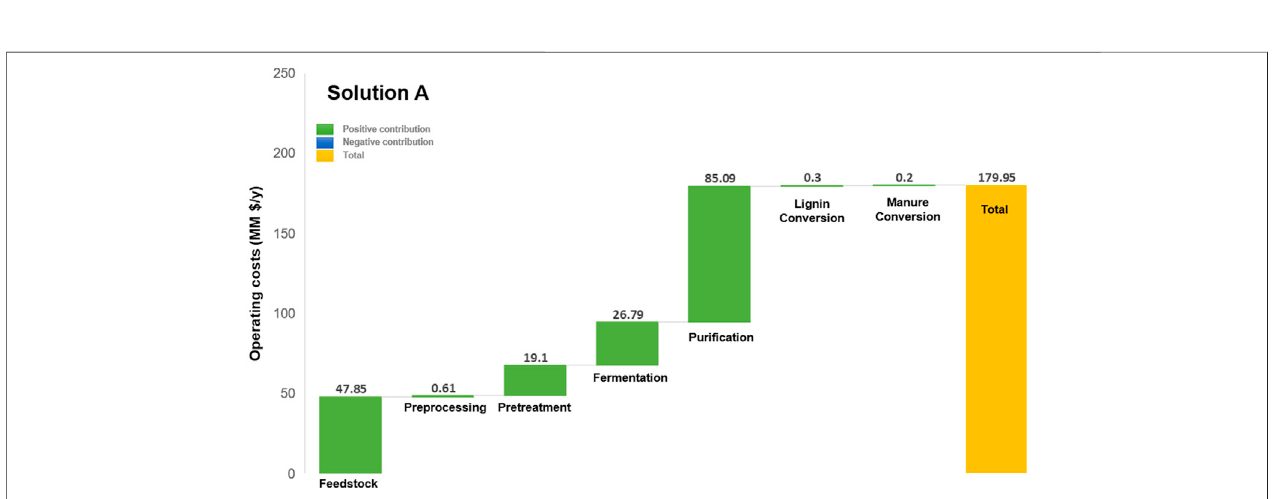
FIGURE 9 | Solution A: operating cost by processing step.